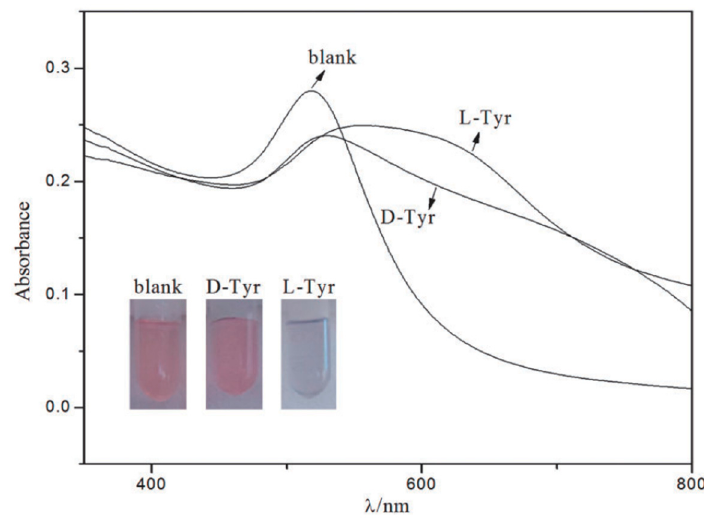
Figure 2. Photographs and UV-vis spectra of EMIML-Tar-AuNPs in the presence of D -Tyr or L -Tyr. Experimental conditions: 1.5 mL EMIML-Tar-AuNPs added with 0.5 mL 1.25 mmol/L D -Tyr or L